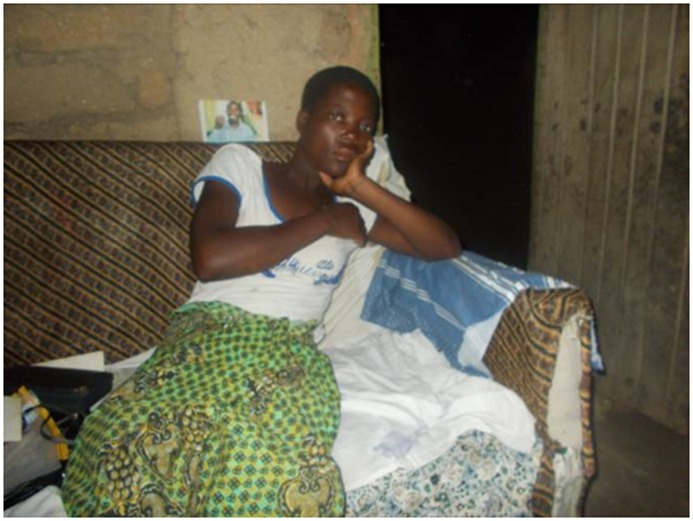
Cancer as a disease.